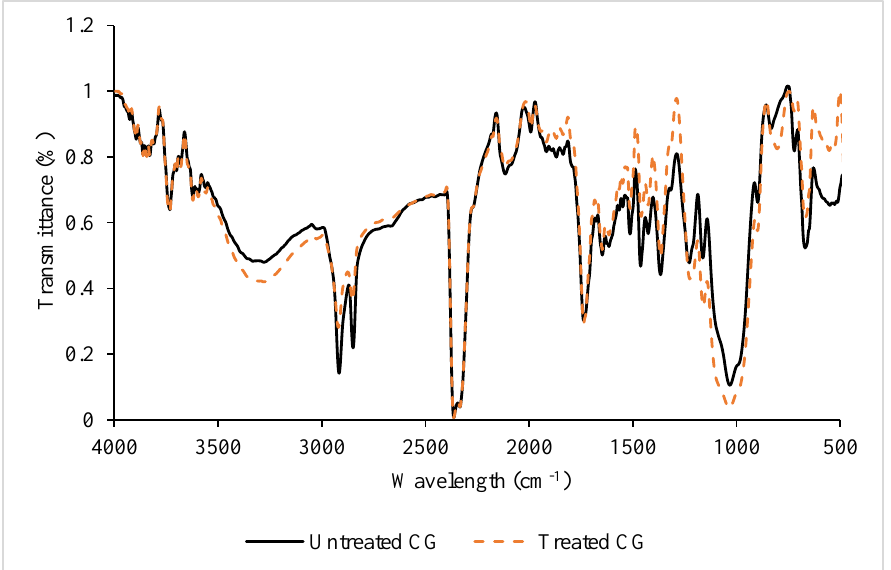
Figure 3. Attenuated total reflectance – Fourier transform infrared (ATR-FTIR) spectra of untreated and treated cogon grass before sorption. Treated cogon grass was heated at 120 °C for 45 min.